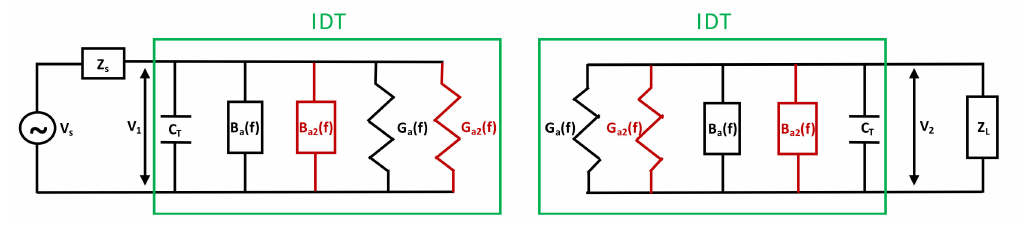
Figure 1. Schematic view of two equivalent circuits which takes into account both surface and volume acoustic